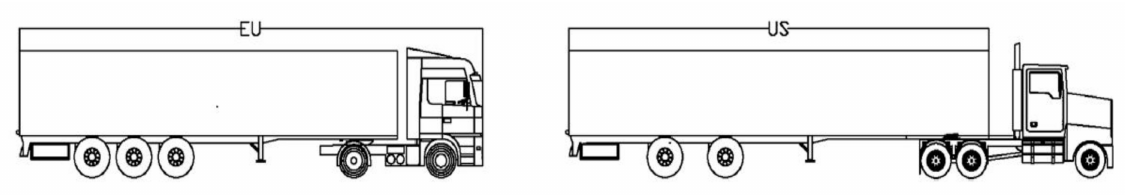
Figure 1. A schematic view of European and American heavy